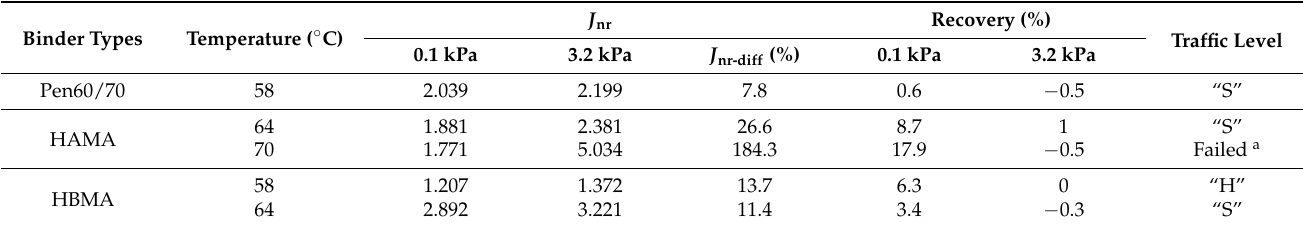
Table 2. Multiple stress creep recovery (MSCR) test results.